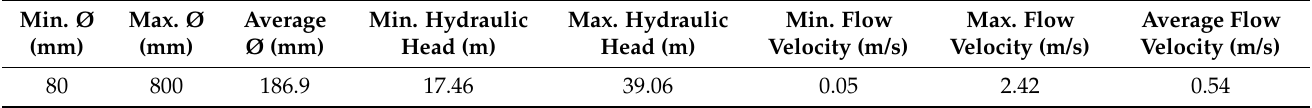
Figure 5. EPANET model of the Cheongna WDN, highlighting the head pressure in the nodes after applying the optimal pipe diameters. Table 6. Outcomes of the Cheongna WDN optimization after applying the HS algorithm.